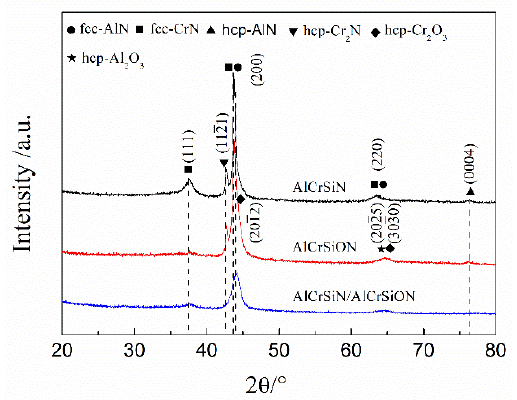
Figure 5. X-ray diffraction patterns of the AlCrSiN coating, AlCrSiON coating, and AlCrSiN/AlCrSiON Figure 5. X-ray di ff raction patterns of the AlCrSiN coating, AlCrSiON coating, and AlCrSiN / AlCrSiON duplex coating. duplex coating.